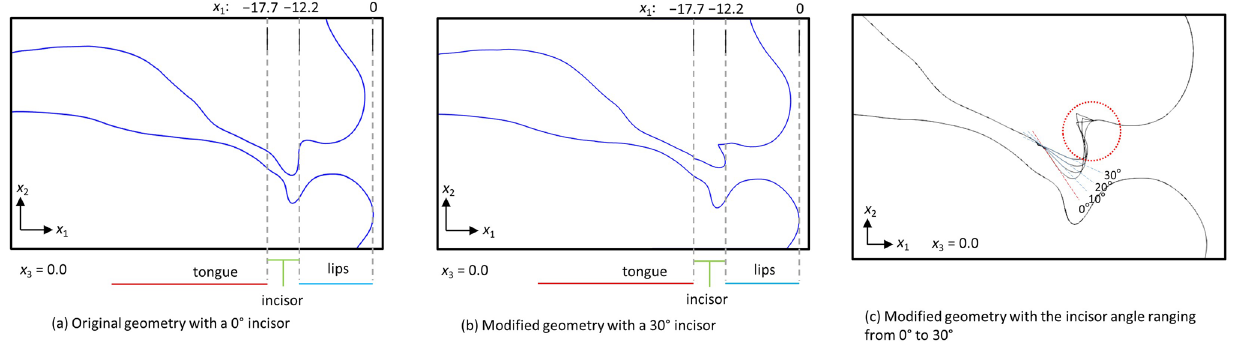
Figure 2. Vocal tract geometry with the incisor angle increased from the original position (0°) to 30°: ( a ) original geometry with 0°; ( b ) modified geometry with 30°; and ( c ) modified geometry with the incisor angle ranging from 0° to